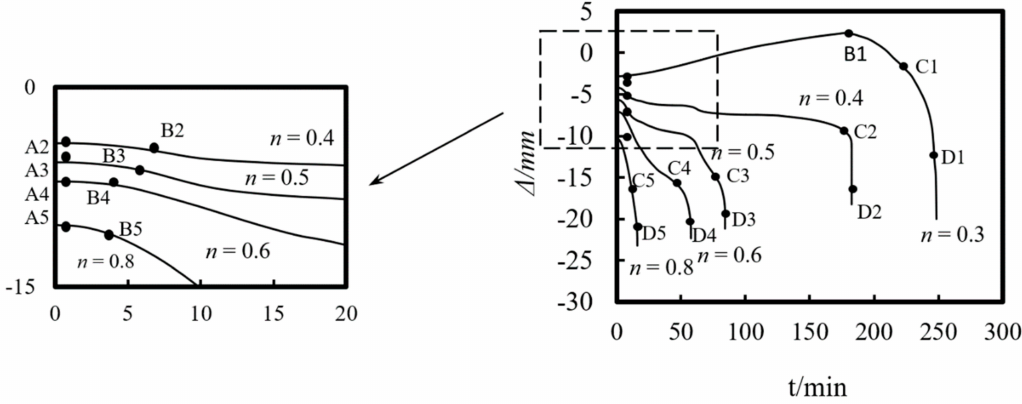
Figure 9. Axial deformation − time curves under different fire load ratios.